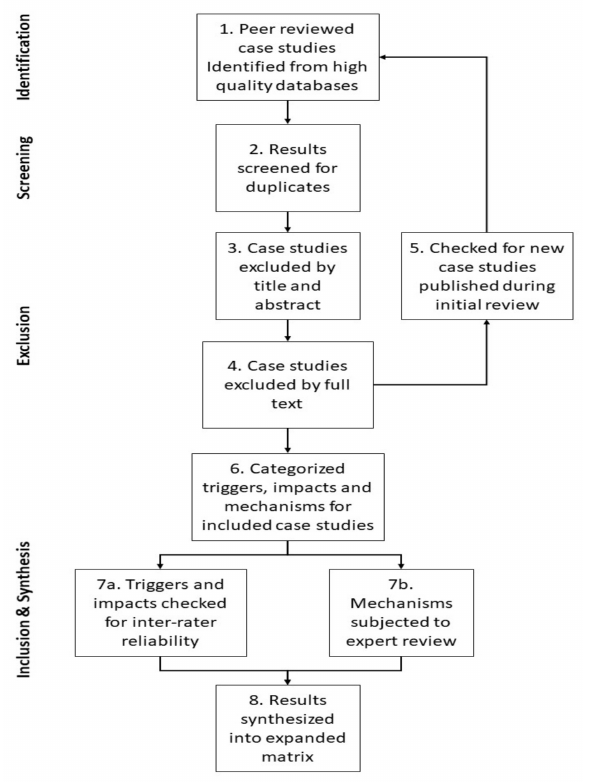
Figure 2. Overall method